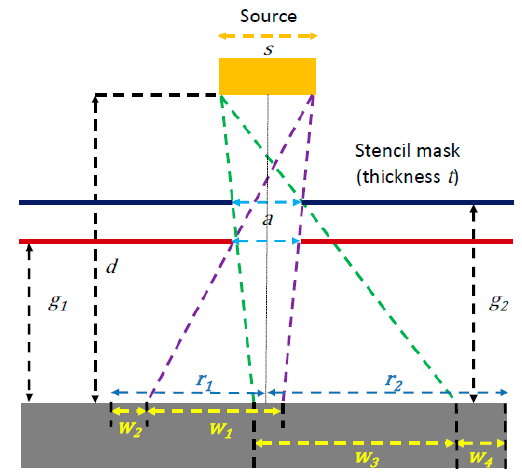
Figure 5. Schematic image of the “blurring” effect. The gap g between the stencil mask and substrate increases the feature size based on the shadowing effect. increases the feature size based on the shadowing